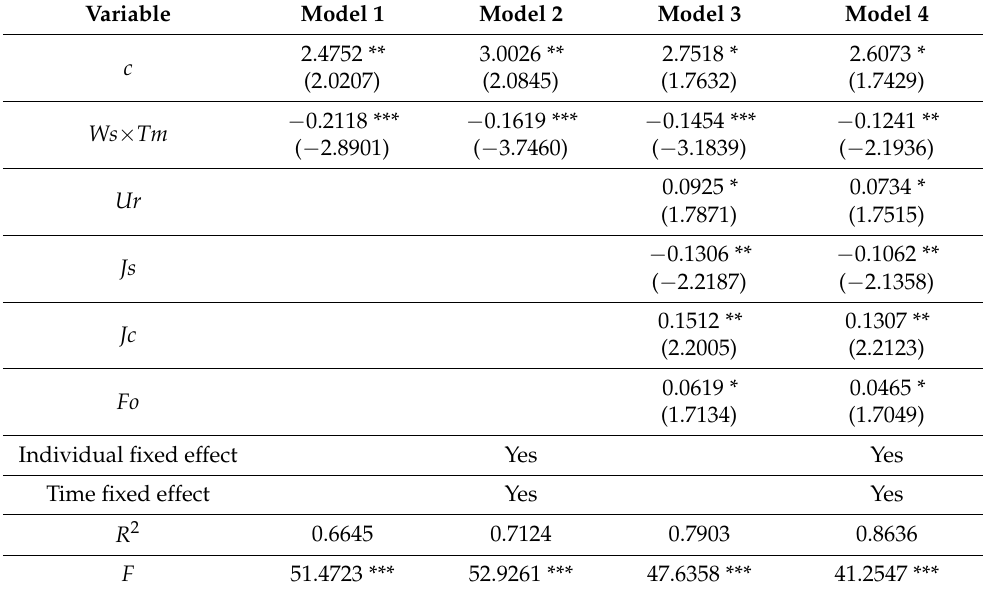
Table 3. Panel difference-in-differences estimation